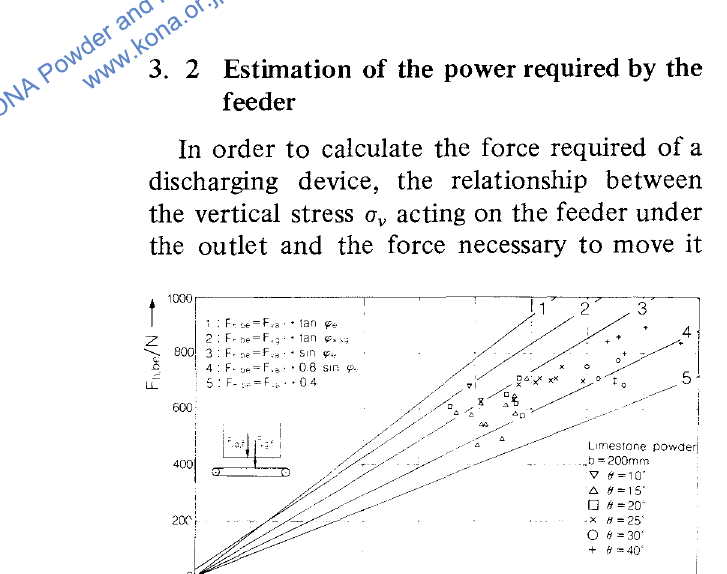
Fig. 3.4 Horizontal force required for removing bulk solid in relationship to the vertical force acting on the